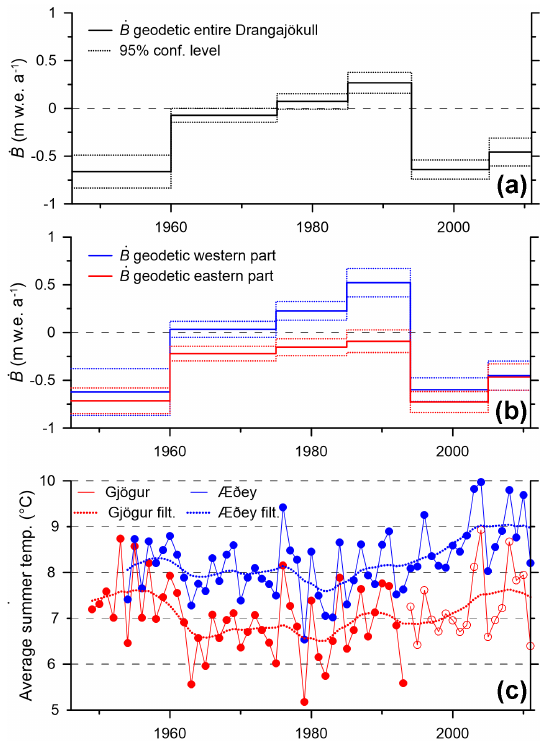
Figure 9. The glacier-wide mass balance rate ( ˙ B) during six differ- ent periods since 1946, calculated for the entire ice cap (a) , and split into the western and the eastern sections of Drangajökull (b) using the ice divides shown as purple lines in Fig. 6. The dotted line in (a) – (b) represents 95% confidence level. Graph (c) shows the av- erage summer temperature at the meteorological stations Gjögur, since 1949, and Æðey since 1954 (see Fig. 1b for locations). Close circles indicate data from manned station, open circles from auto- matic station. The dotted lines show the average summer tempera- ture at each location filtered with 11-year triangular weighted run- ning